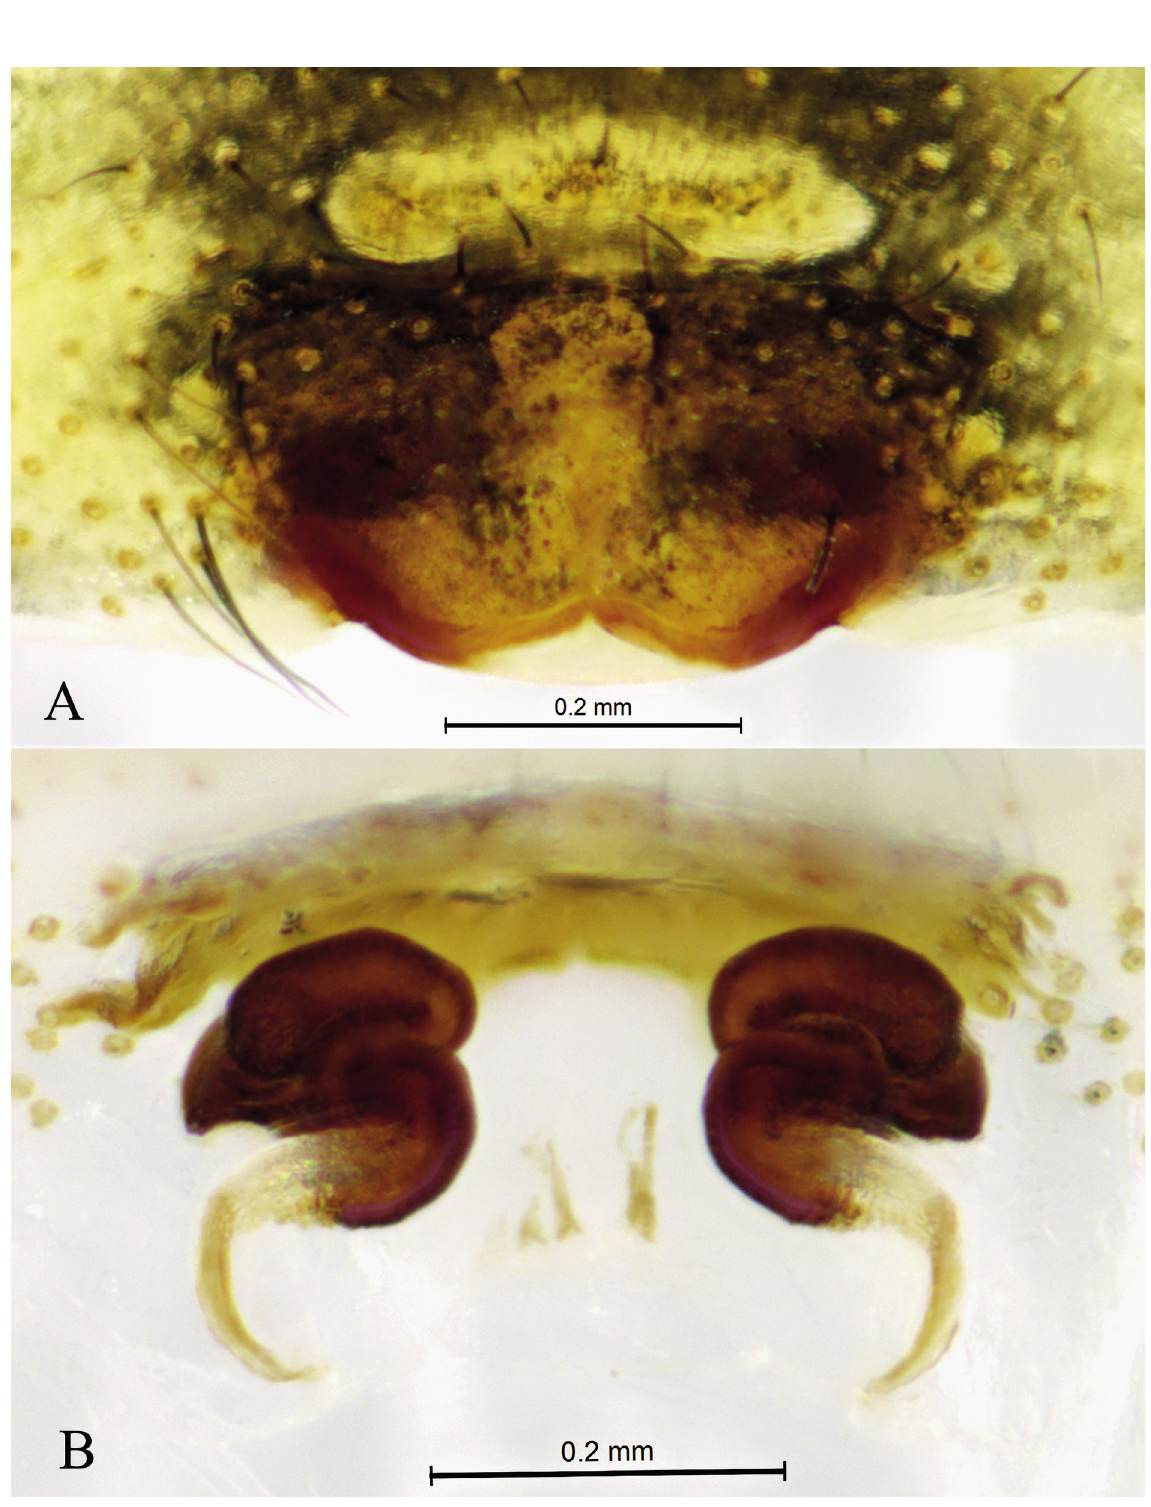
Fig. 12. Meta hongyuan sp. nov., ♀, paratype (SWUC-T-TEg-05-03). A . Epigyne, ventral view. B . Vulva, dorsal